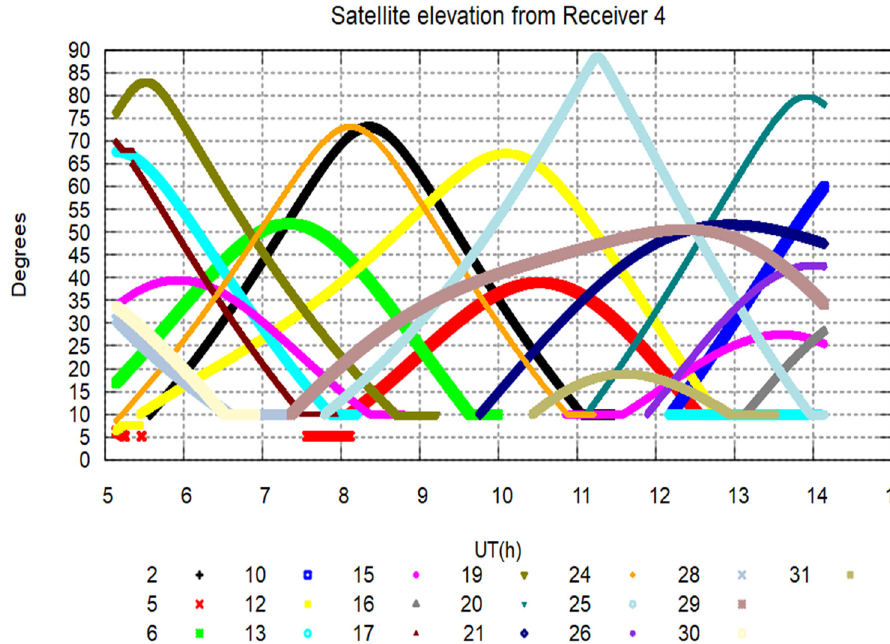
Figure 7: Satellite elevation angle for Rec 4.